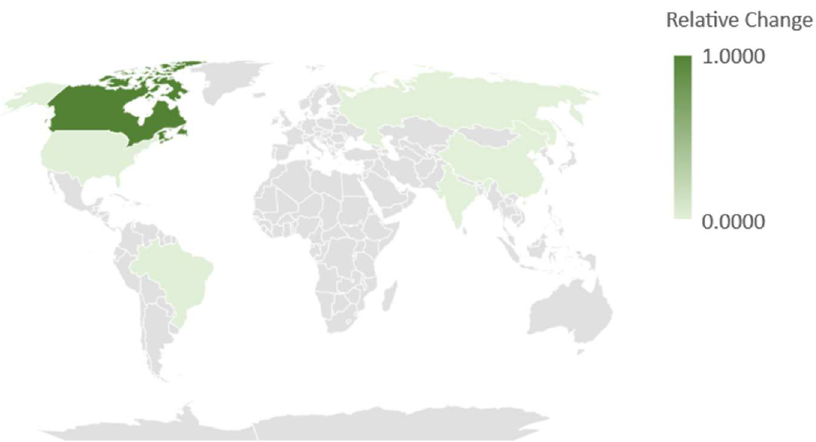
Figure 2. Relative change in agricultural area from 1500–2016 (data source: Statista).